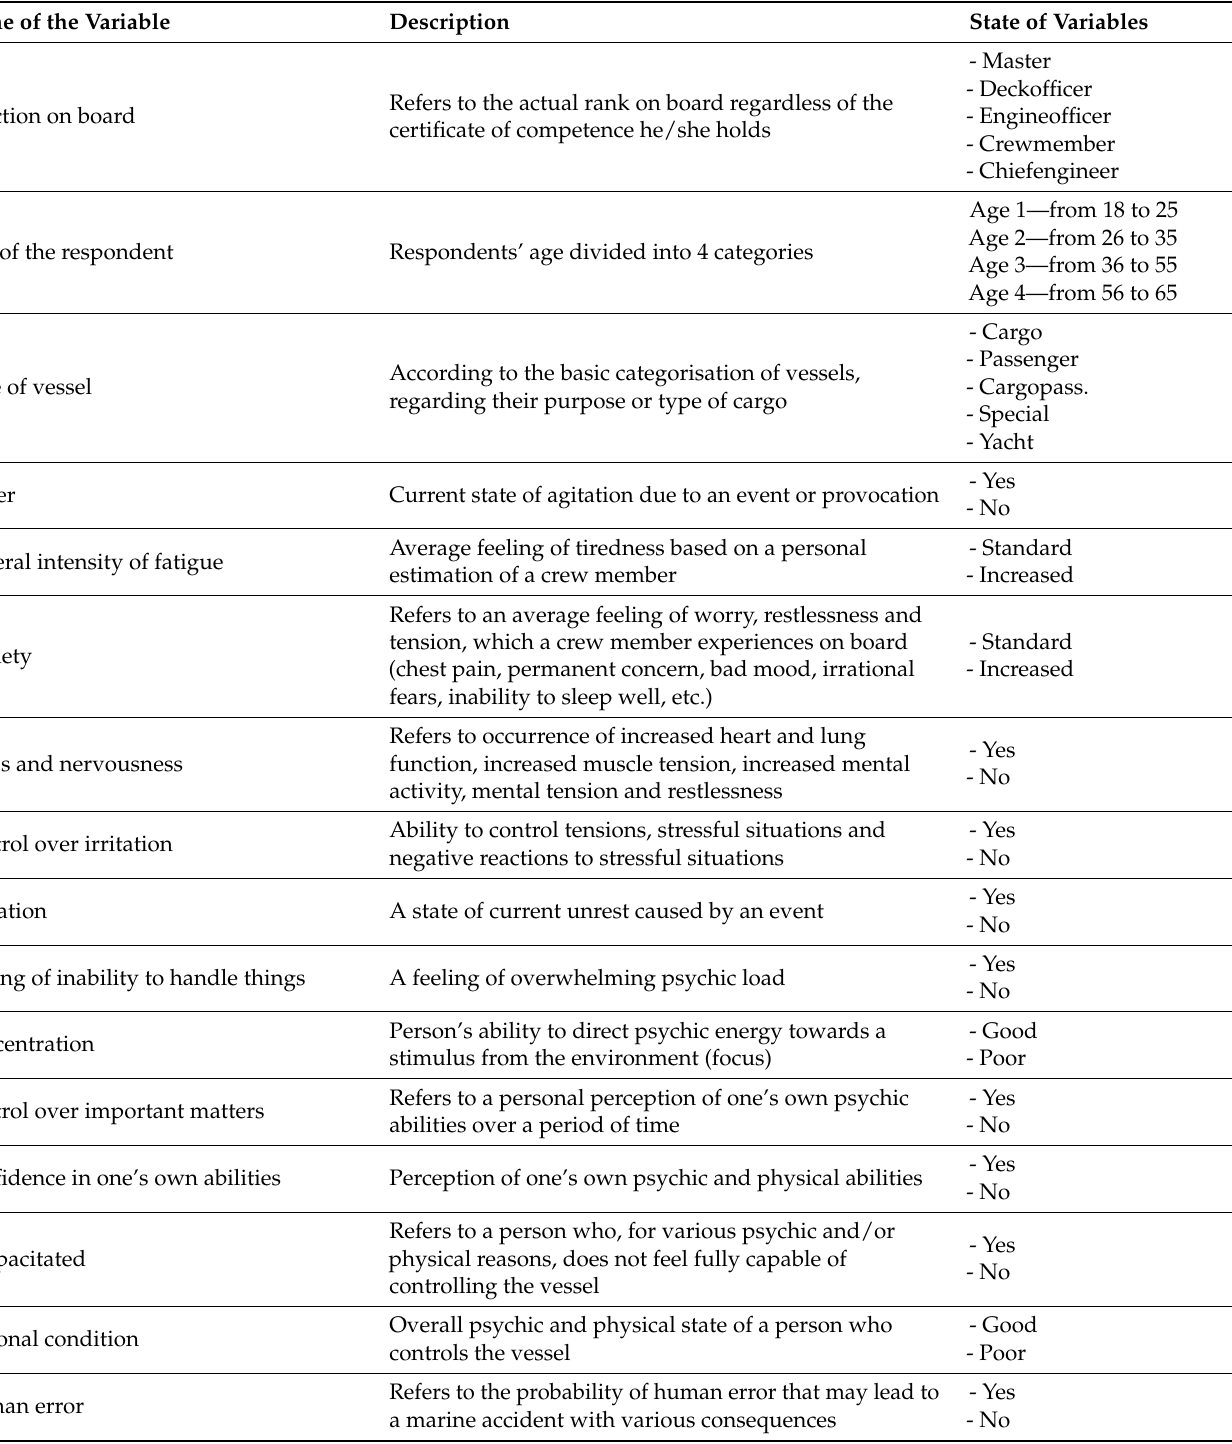
Table 2. Description of the